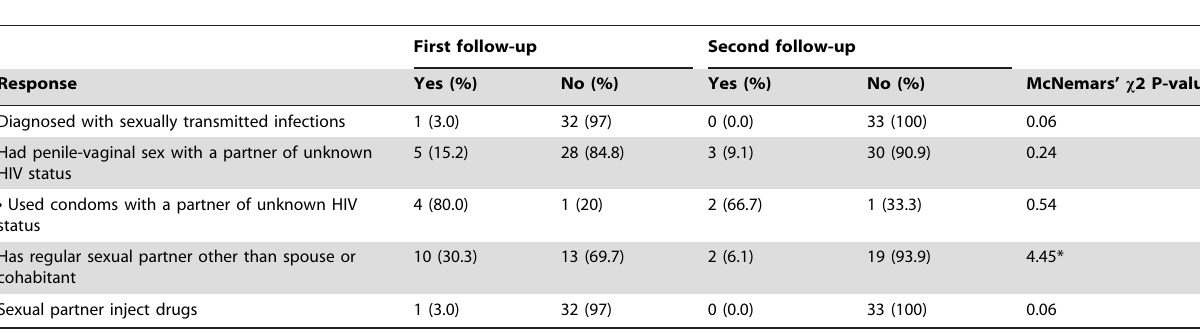
Table 6. Sexual practices and outcomes within the previous six